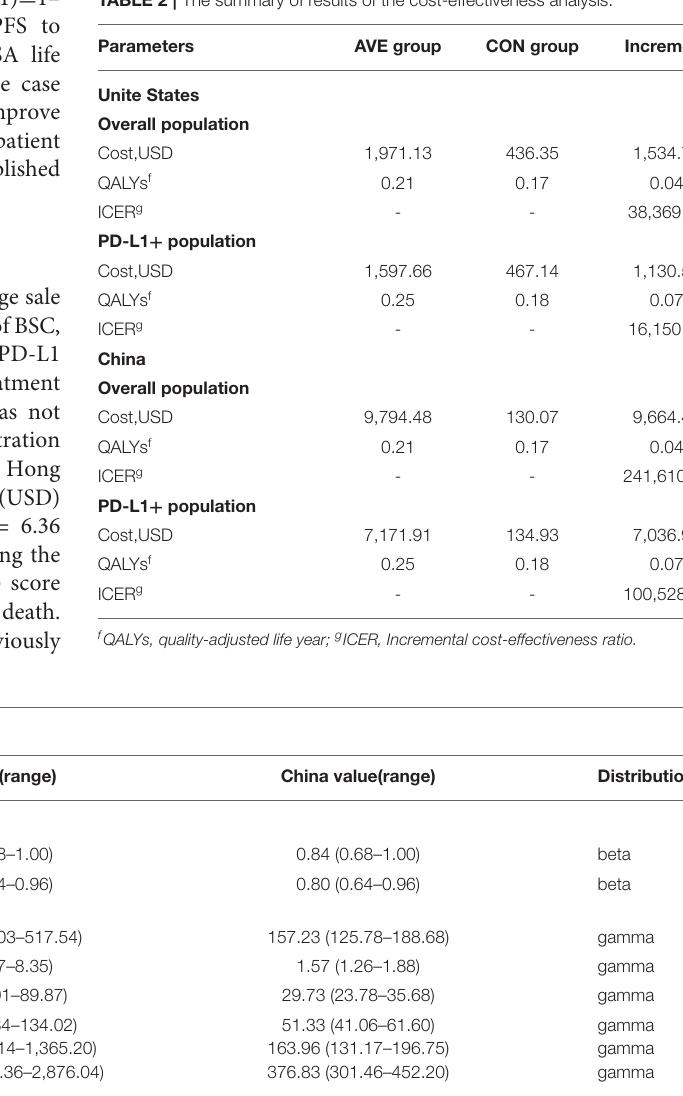
TABLE 2 | The summary of results of the cost-effectiveness analysis.